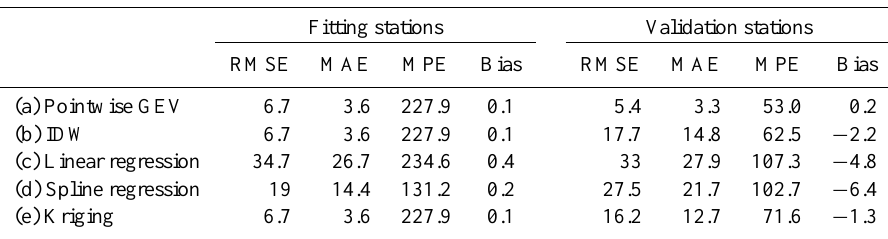
Table 2. Scores of quantile comparison when (a) fitting a GEV to each station separately as in Sect. 4; (b)–(e) interpolating the GEV parameters with a DEM as covariate.